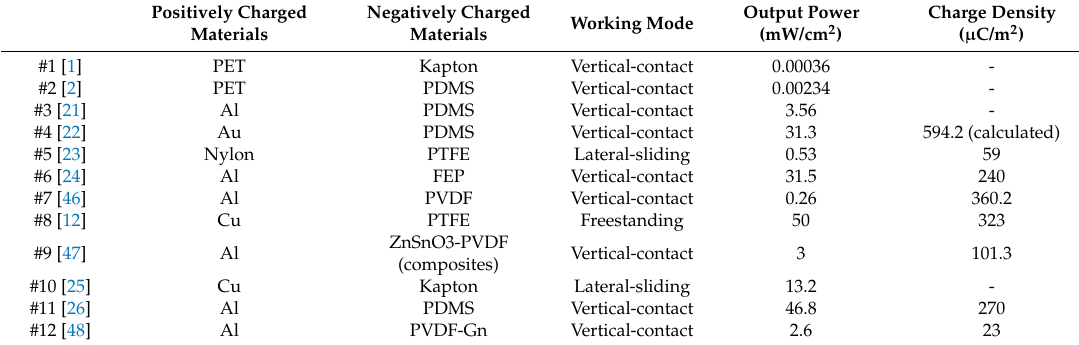
Figure 1. The areal power densities and output currents of various triboelectric nanogenerators (TENGs) reported for the last 5 years [45]. Reproduced with permission from Lee et al., APL Materials Table 1. The areal power densities, output currents, and charge densities of various triboelectric nanogenerators (TENGs) reported for the last 5 years.